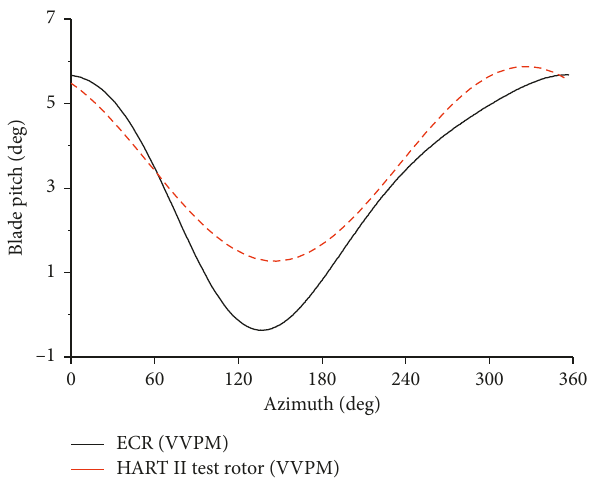
Figure 5: Variation of blade pitch of the ECR and the conventional rotor versus azimuth